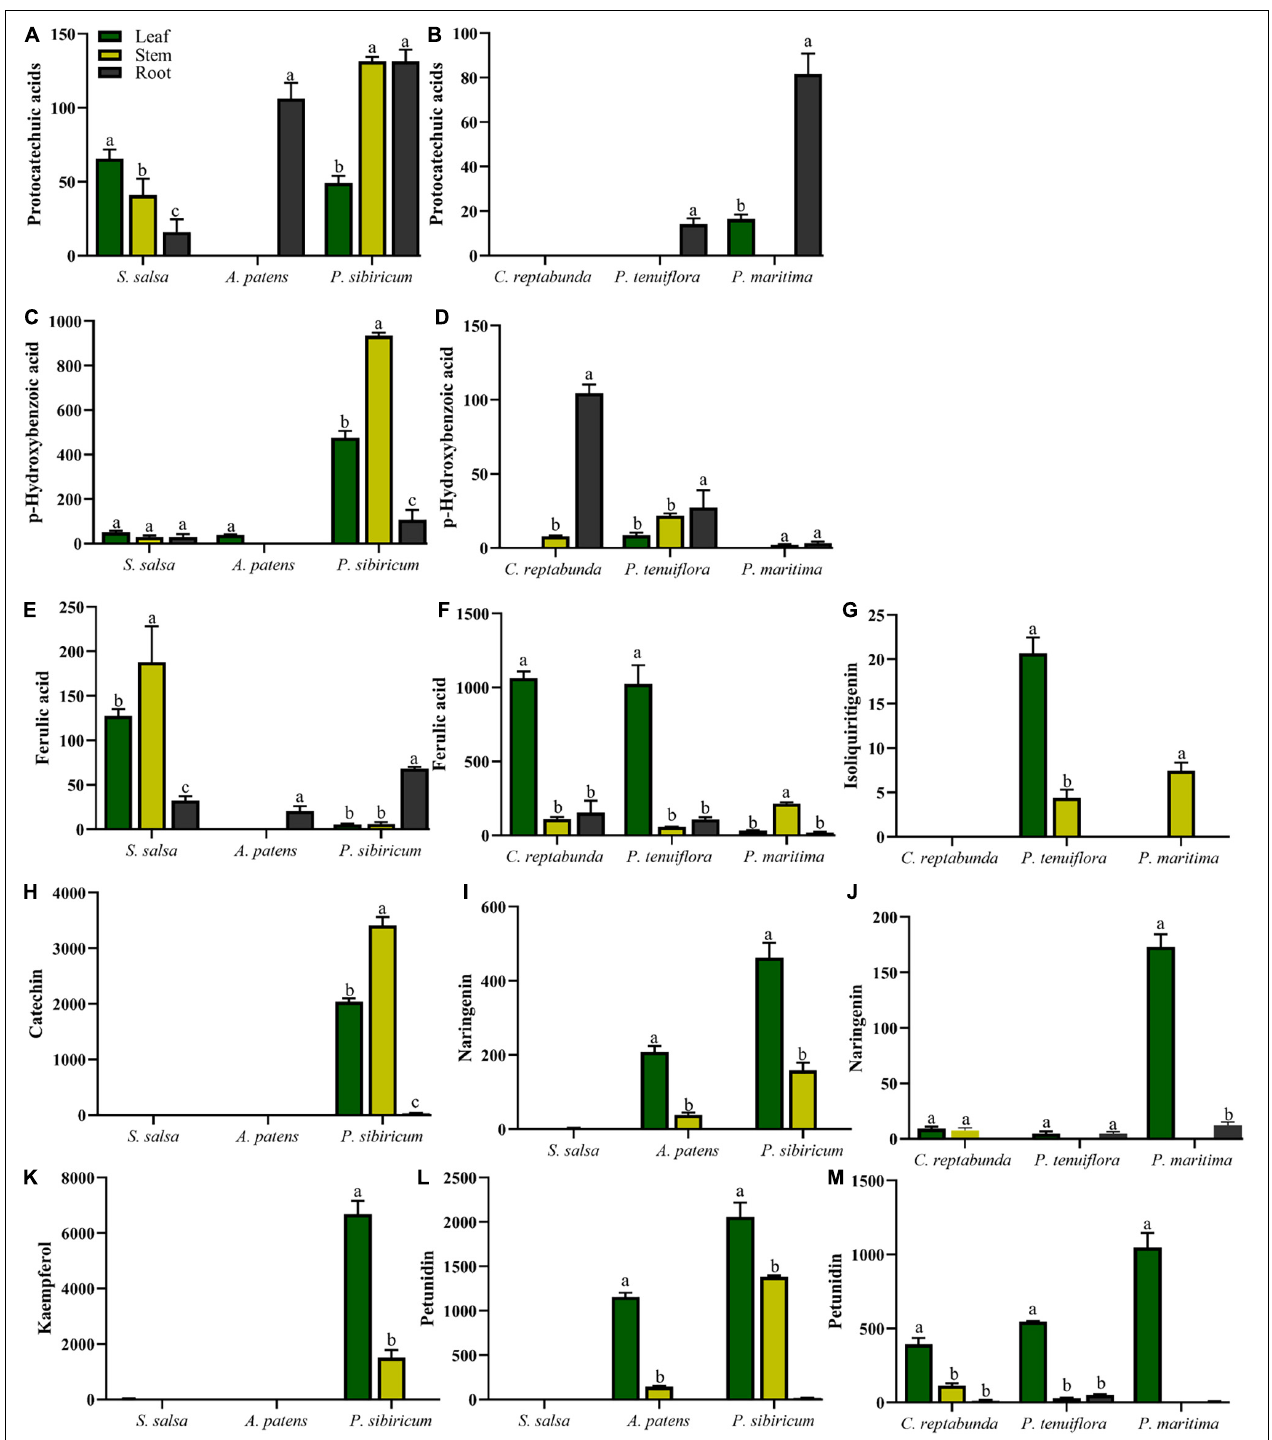
FIGURE 5 | Relative contents of significantly different phenolic compounds in S. salsa community and P. tenuiflora community: (A,C) relative contents of C6C1-compounds in S. salsa community; (B,D) relative contents of C6C1-compounds in P. tenuiflora community; (E) relative contents of C6C3-compounds in S. salsa community; (F,G) relative contents of C6C3-compounds in P. tenuiflora community (H,I,K,L) relative contents of C6C3C6-compounds in S. salsa community (J,M) relative contents of C6C3C6-compounds in P. tenuiflora community; The accumulation of significantly different elements is summarized from 3 biological replicates and presented as the mean ± standard error. Different letters indicate significant differences among treatments ( p < 0.05).